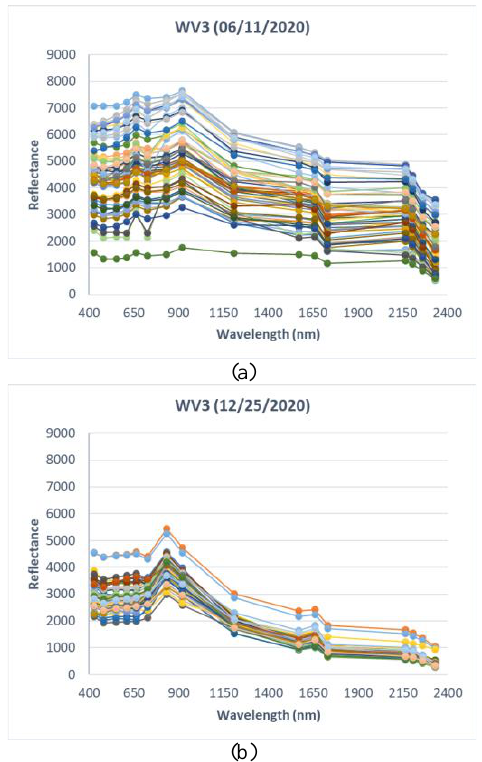
Figure 6 . Spectral signature plots extracted from WV3 images for each of the 50 PCG samples. (a) Summer period. (b) Winter period.